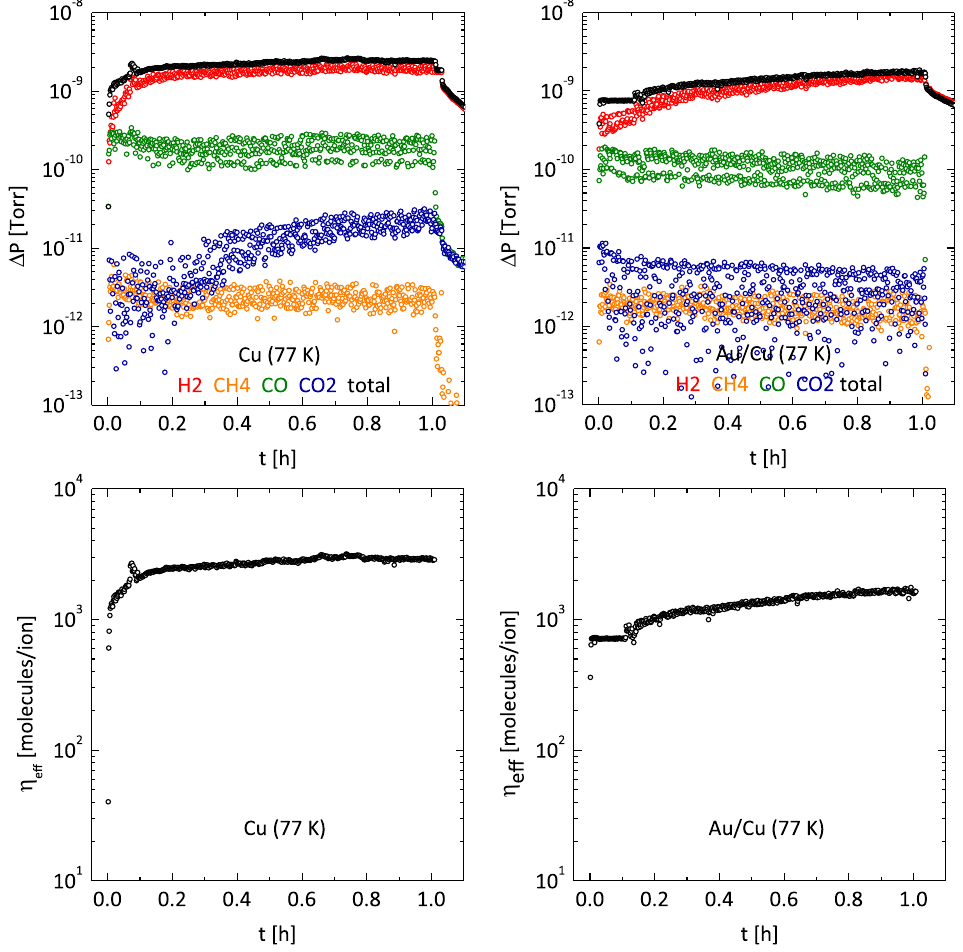
FIG. 3. Heavy-ion-induced gas desorption measurements at 77 K target temperature. Partial pressure rises ( (cid:2) P ) of H 2 , CH 4 , CO, CO 2 and total pressure measured for bare and gold-coated copper samples continuously bombarded under Pb 54 þ ions are shown together with the corresponding desorption yields ( (cid:2)